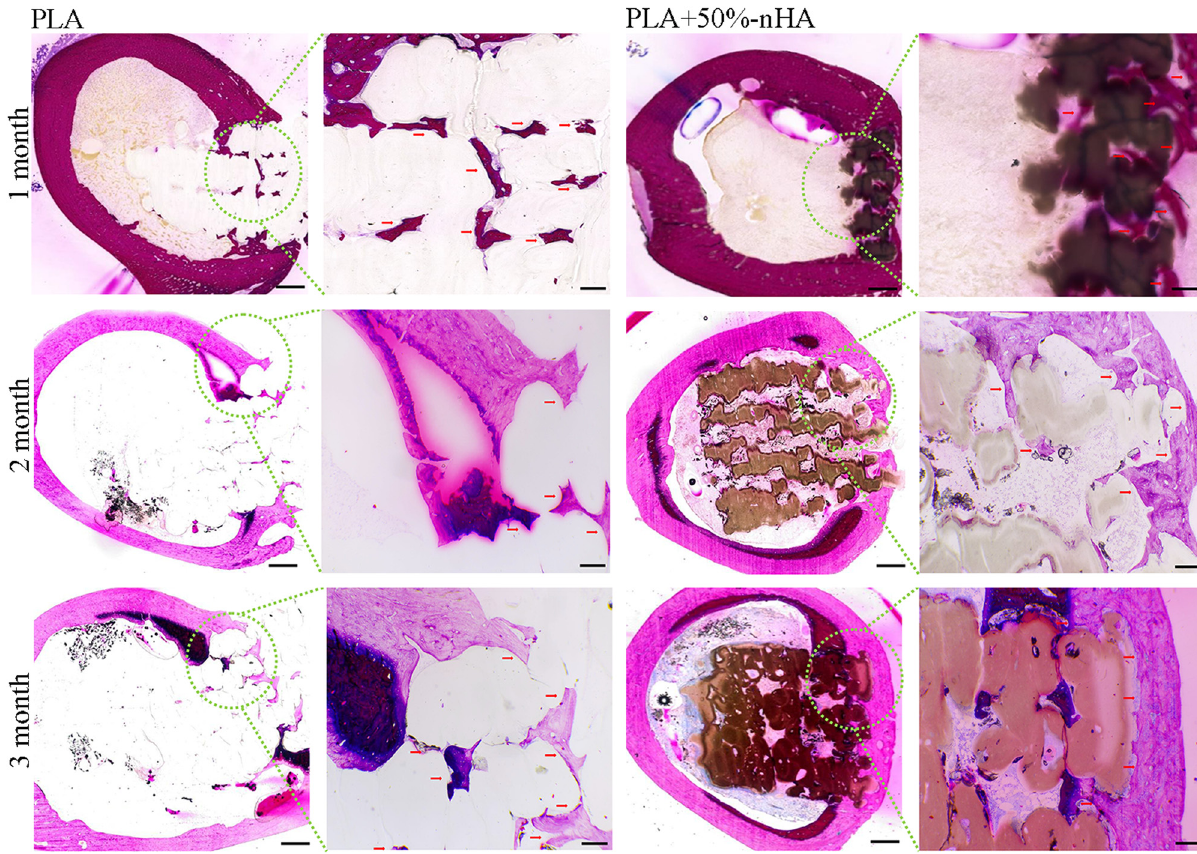
Figure 8: Hematoxylin – eosin ( HE ) staining of the implanted sca ff olds. New bone growth of PLA and PLA/n - HA composite sca ff olds were observed at 1, 2, and 3 months after implantation. The observation of the whole interface are shown in the fi rst and third